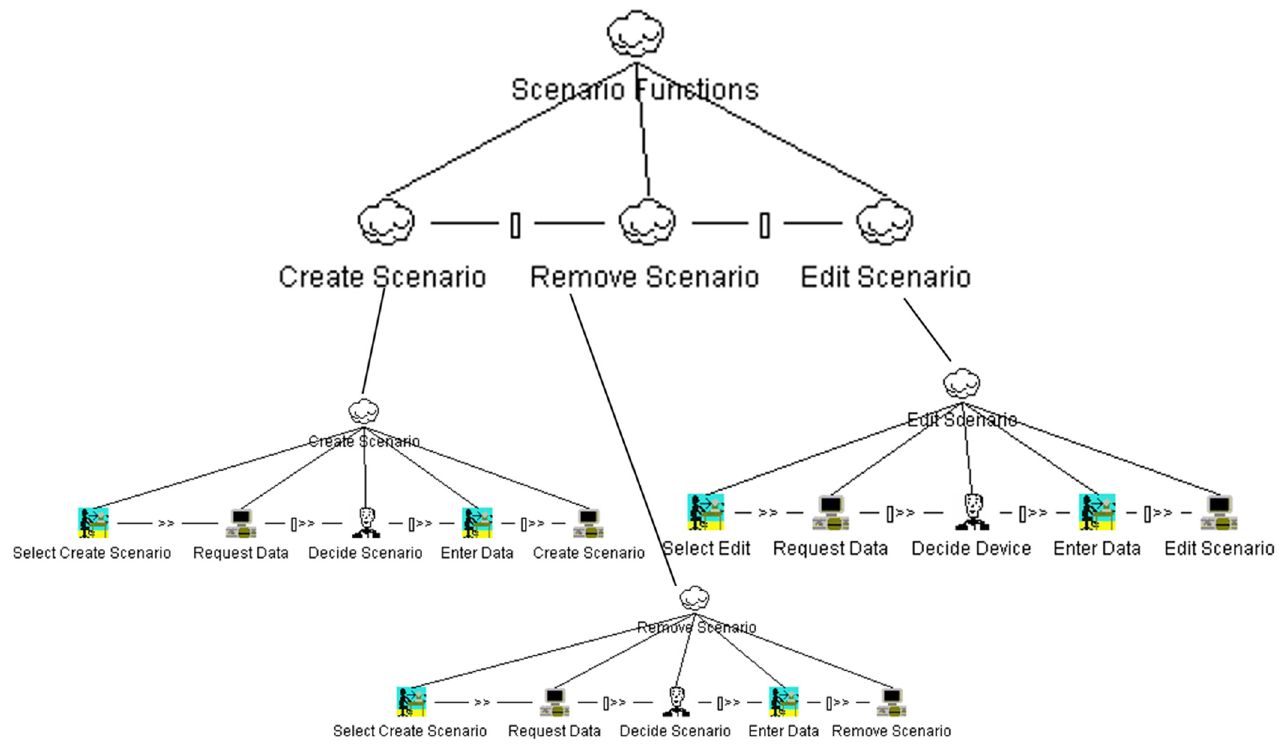
Figure 2. Task Model of the scenarios’ definition of a demand home energy management system with IoT.